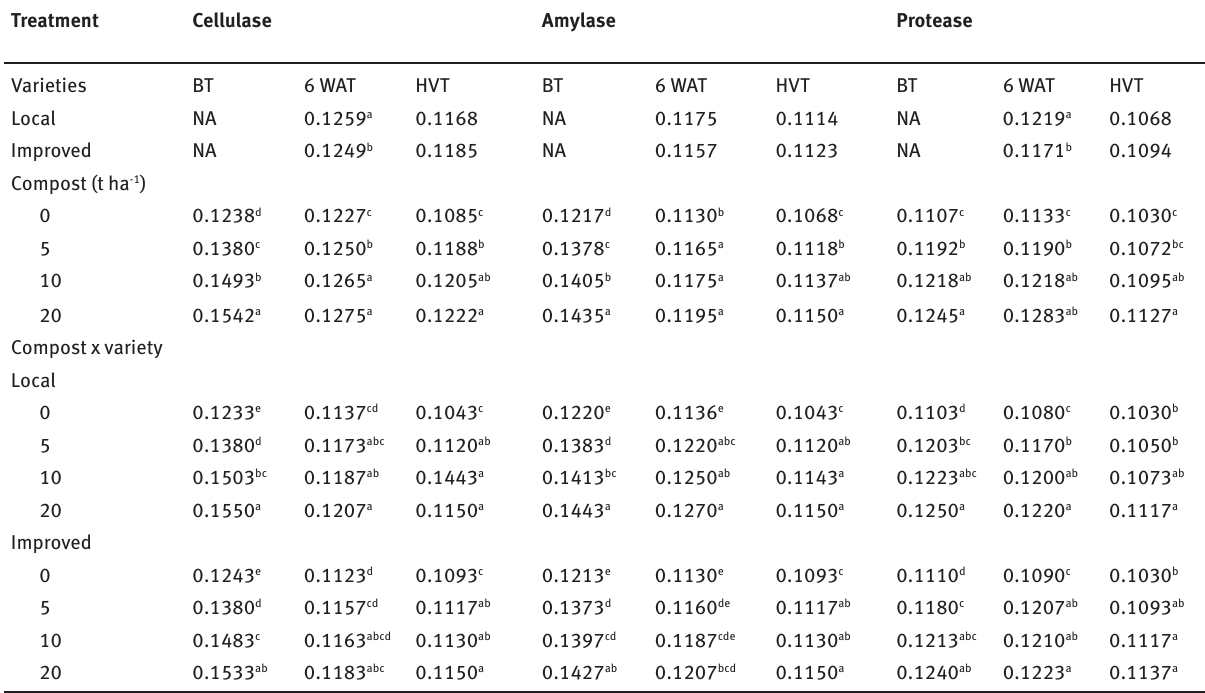
Table 3: Soil cellulase, amylase and protease activities (µg g -1 ) at 3 sampling periods in the second pot experiment amended with 4 rates of compost and sown to 2 tomato varieties